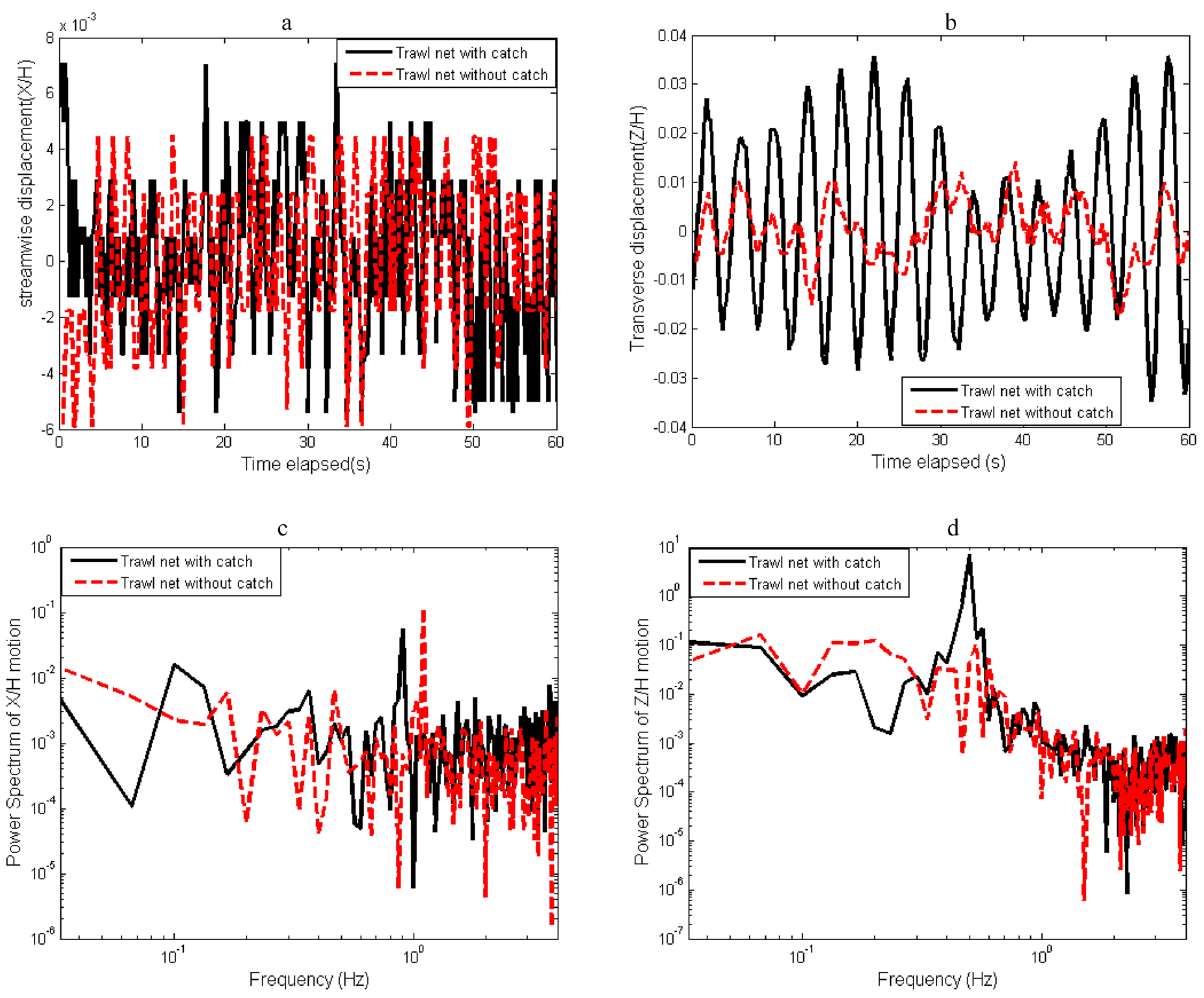
Figure 8. ( a ) Fluctuations of the x-structure motion normalized with the net mouth height (H). ( b ) Fluctuations of the normalized z-structure motion. ( c ) Spectral representation of x-structure motion, and ( d ) Spectral representation of z-structure motion (in a log–log